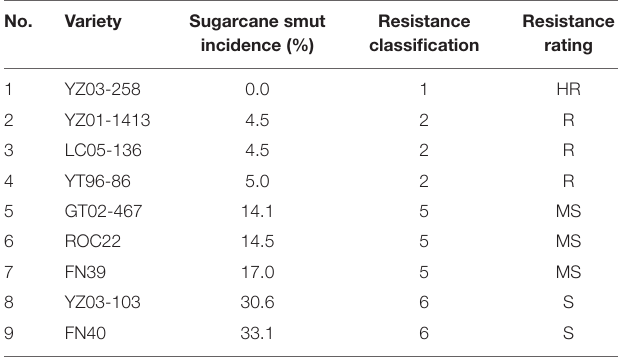
TABLE 1 | Nine sugarcane varieties with different resistance to smut after identification in the field.